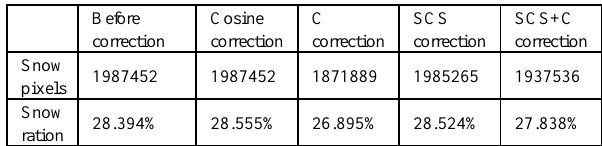
Table 2. Snow cover ration before and after topographic